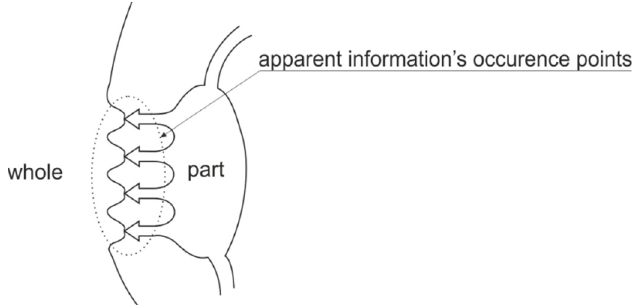
Figure 5. Apparent information localization in the knowledge circulating process.